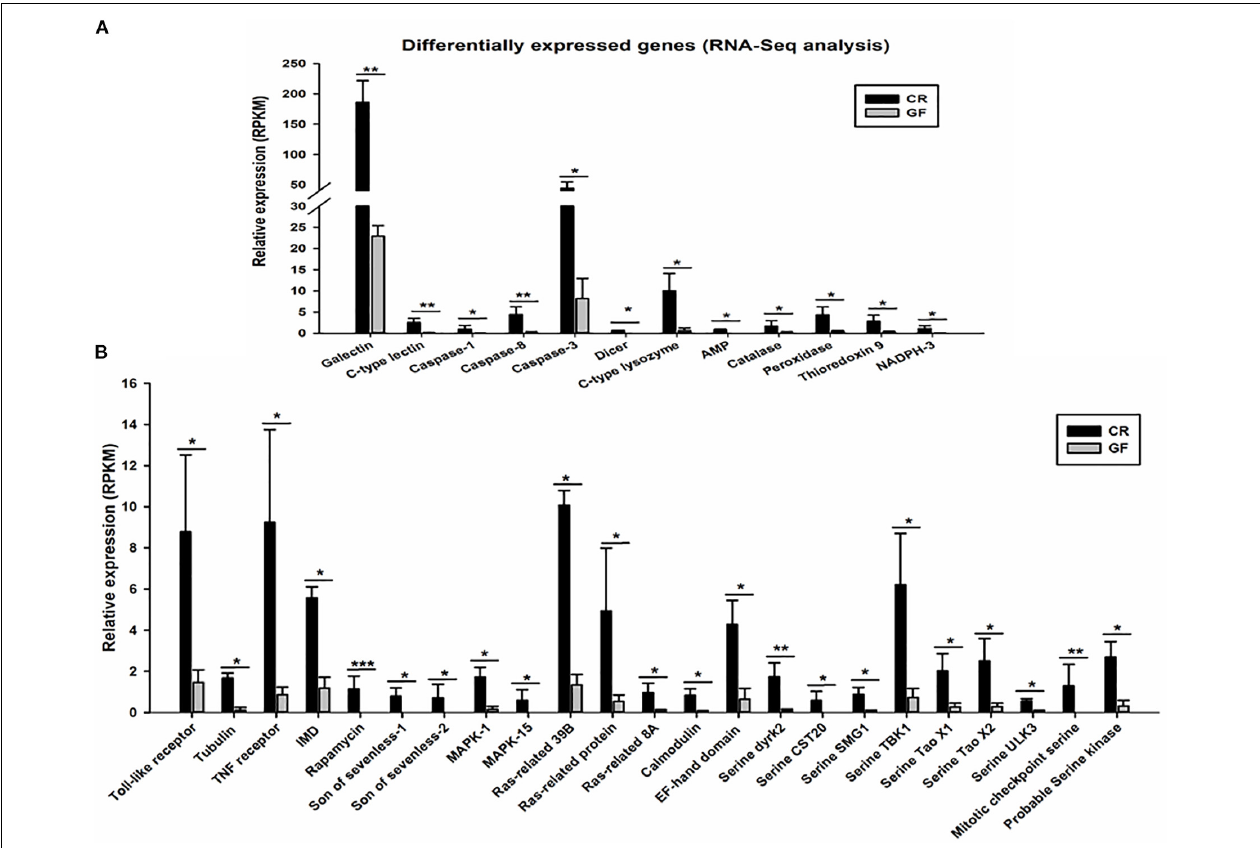
FIGURE 5 | Expression profile of differentially expressed immune related genes (35 genes). RNA-Seq analysis identified immune recognition, immune effectors, and other immune genes (A) and immune signaling genes (B) significantly downregulated in the guts of GF RPW larvae. The False Discovery Rate (FDR) value was set at P < 0.05 and twofold change only for the unigene to be considered as differently expressed genes (DEGs). ∗ P < 0.05, ∗∗ P < 0.01, ∗∗∗ P < 0.001.